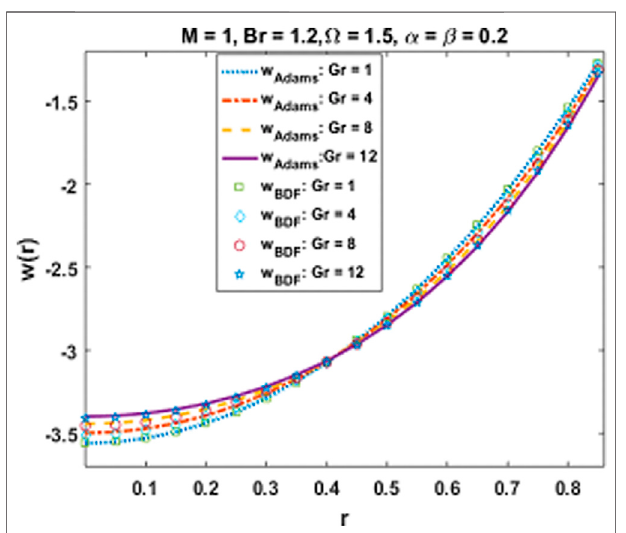
FIGURE 8 | Behavior of axial velocity against Grashof number.